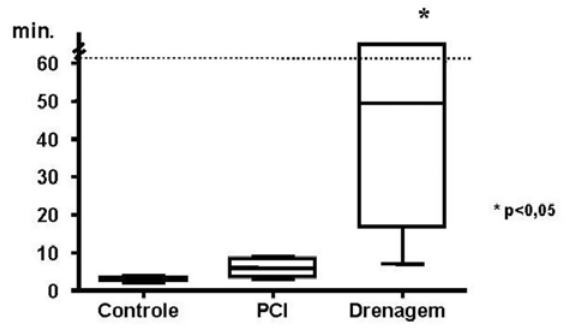
Fig. 4 - Tempo de perda do PESS, na fase de oclusão da aorta, nos três grupos